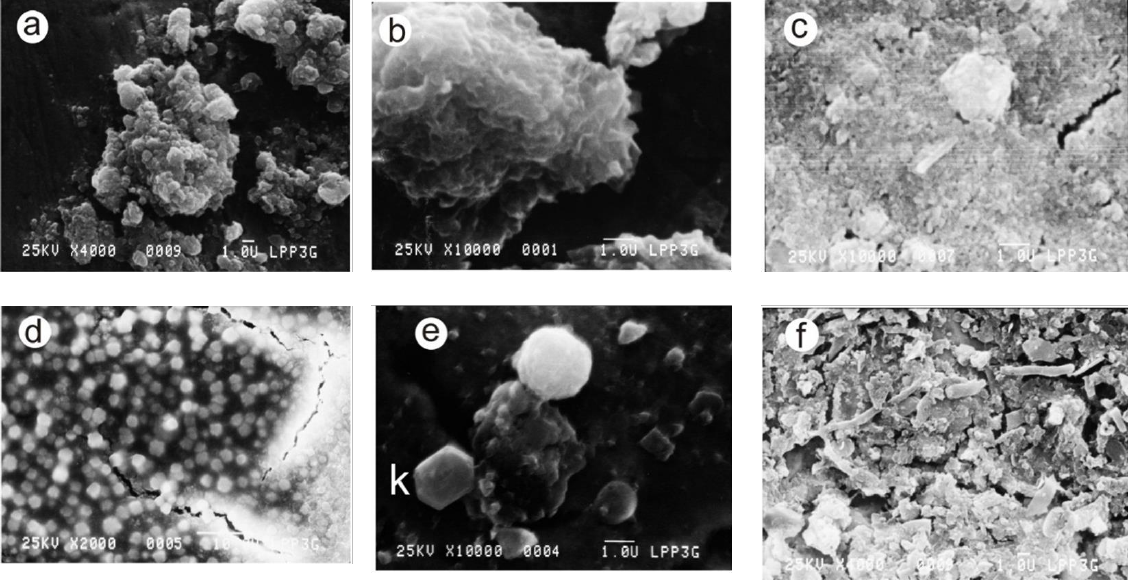
Figure 5. Photomicrograph obtained by scanning electron microscopy. Allophane (A) in the B’wb horizon. SDP-B ( a ); imogolite (Im) in the Ap horizon, SNR-B ( b ); halloysite (H) in the BC horizon, SDP-A ( c ); gibbsite (Gb) in the BC’b horizon, SNR-A ( d ); kaolinite in the Ap horizon, CTR-A ( e ); diatom (D) in the Ap horizon, SNR-B ( f